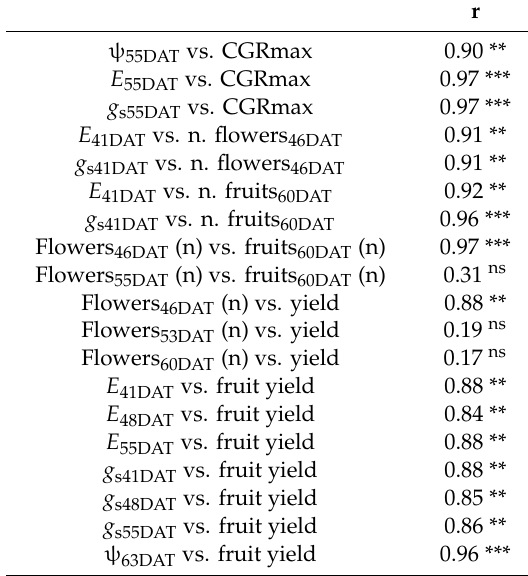
Table 5. Correlation coe ffi cients (r) among the physiological and productive traits in processing tomatoes cv. Hypeel F1. CGRmax: maximum crop growth